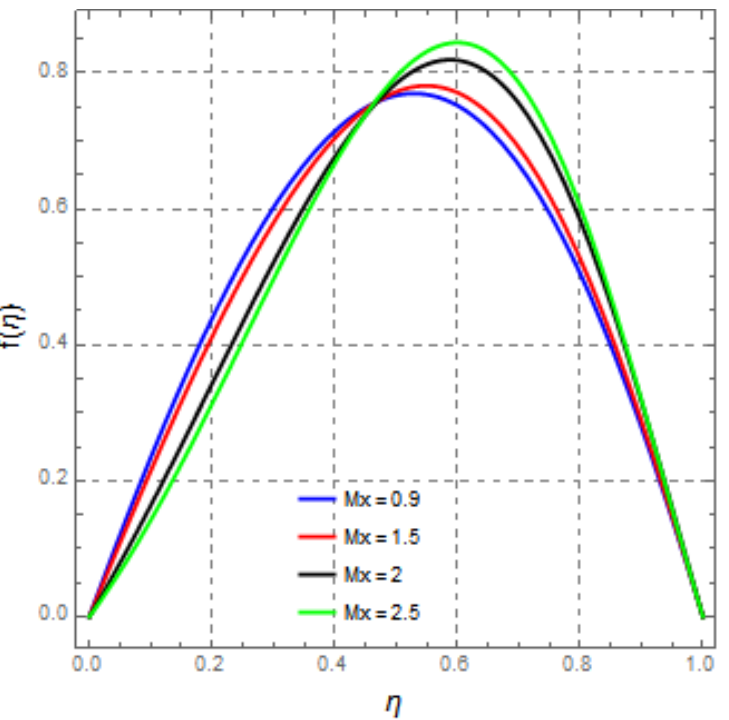
Figure 9. Impact of magnetic field strength M x on velocity component f (cid:48) , keeping S z = − 2, M y = 3, R m = 1, and S = 1.